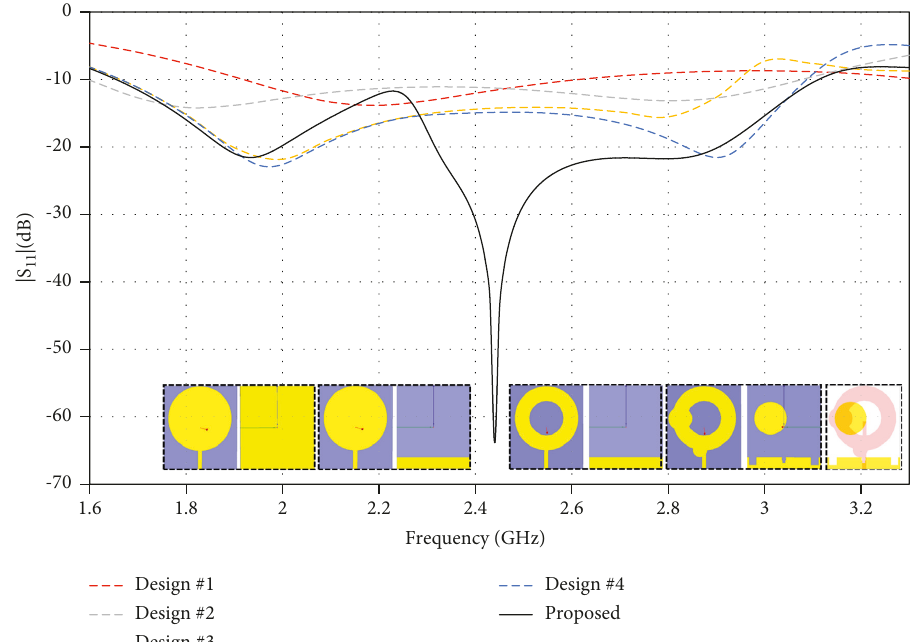
Figure 3: Design approach for optimizing the proposed wideband circular-slot antenna from a basic circular antenna structure.